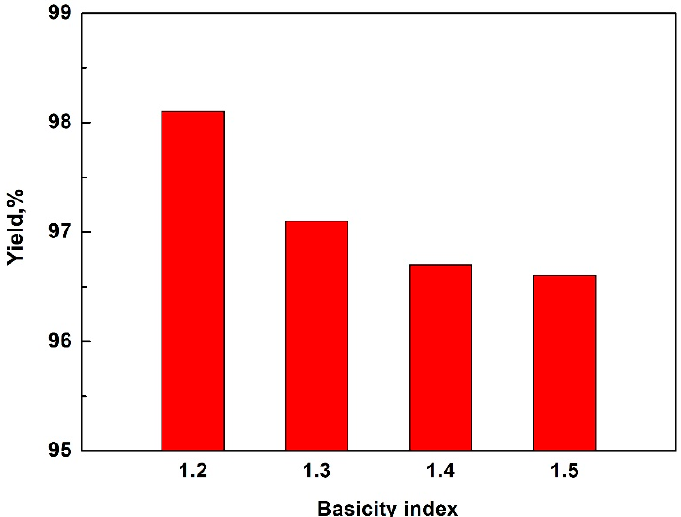
Figure 4. Effect of basicity index of slags on the yield of silicon after 15 min of refining.